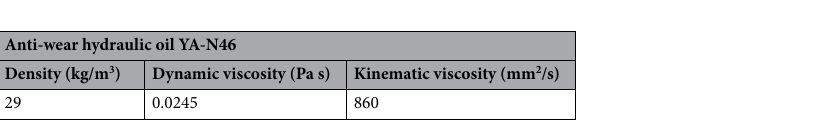
Table 1. Material characteristics of oil in regulating valve.